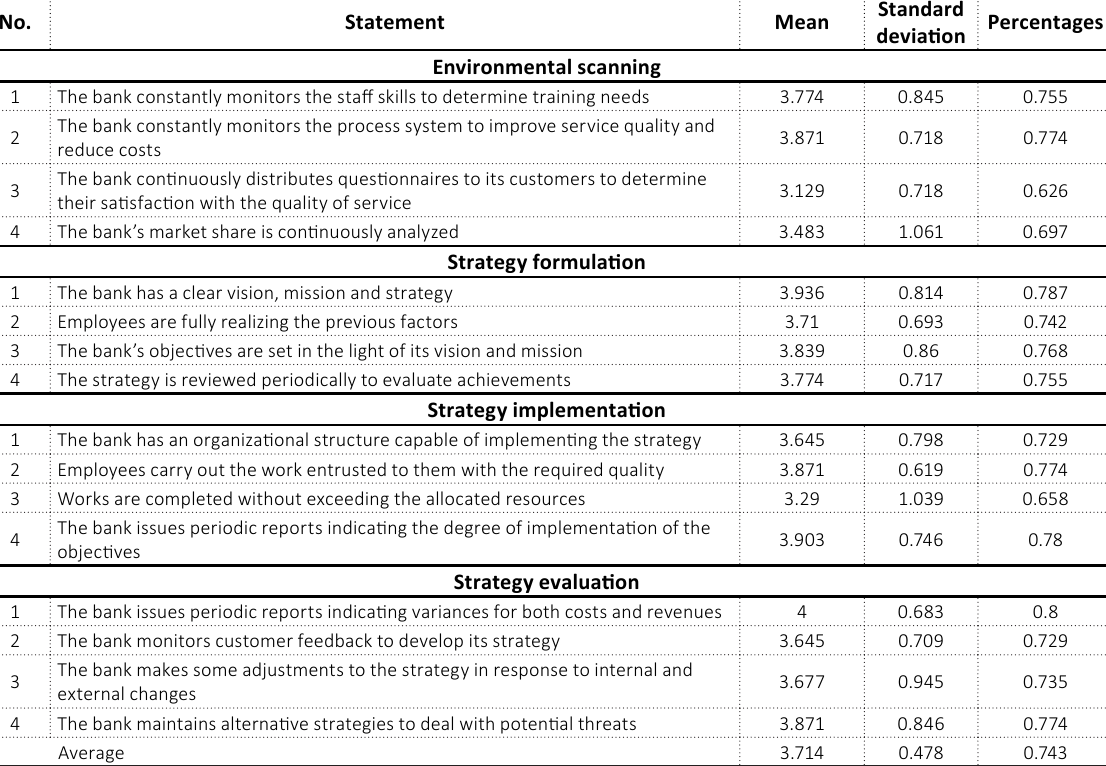
Table 3. Descriptive statistics of responses for the independent variable (strategic planning) No.